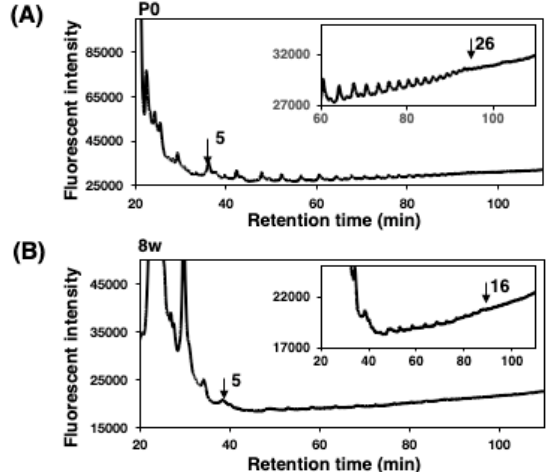
Figure 6. Mild acid hydrolysis–fluorometric anion-exchange chromatography analysis (oligo-analysis) of brain homogenates derived from mouse brains at di ff erent developmental stages (P0 and 8 w). Oligo / polySia analysis was applied for the detection of max. DP of the minimum polySia chain (polySia is easy to degrade). Brain homogenates (100 µ g as protein) of P0 and 8 w were subjected to mild acid hydrolysis followed by DMB derivatization. DMB-labeled oligo / polySia chains were separated by an anion-exchange chromatography–HPLC analysis. Chromatogram of P0 ( A ) as an embryonic brain. Chromatogram of 8 w as an adult brain ( B ).